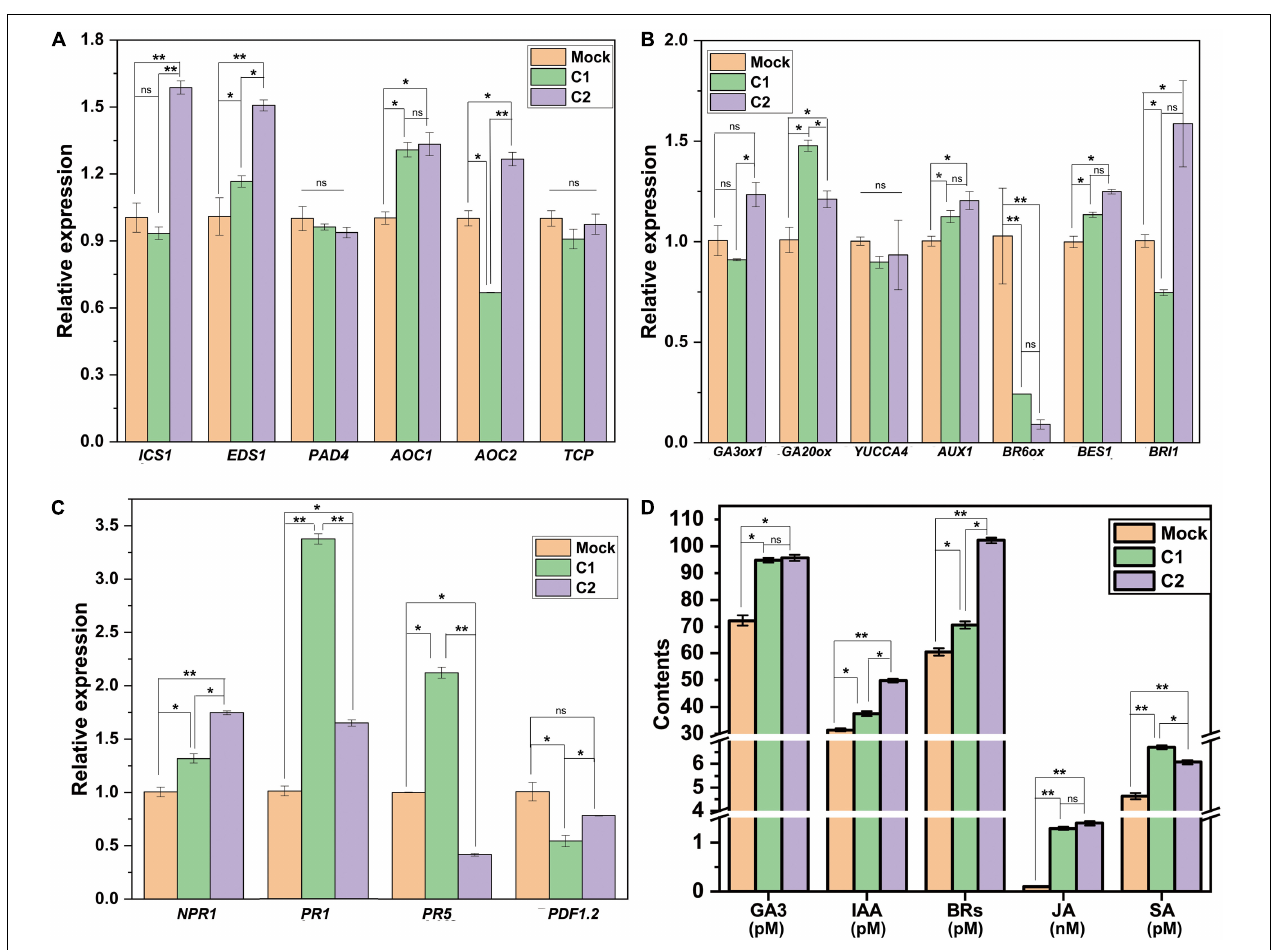
FIGURE 2 | Changes in cotton hormones and related gene expression 30 days after GN03 inoculation. Relative expression of (A) SA and JA synthesis-related gene, (B) IAA, GA, BR synthesis-related genes, and (C) disease resistance-related genes, assessed with RT-qPCR. (D) Hormone content of cotton leaves. In the graphs, mean values with SD are indicated; statistical significance was evaluated by one-way ANOVA and LSD post hoc test (* p < 0.05, ** p < 0.01; ns, not significant, n =